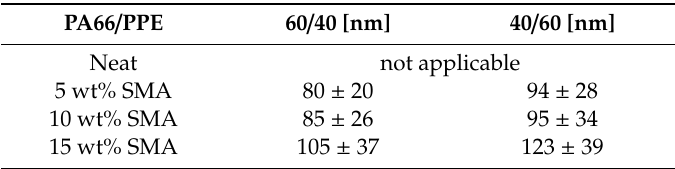
Table 4. Size distribution analysis of swollen Styrene-maleic anhydride copolymer-graft-polyamide 66 (SMA-g-PA66) micelles found in the PA66 phase, determined from the TEM micrographs in Figure 4, with a size filter between 0–200